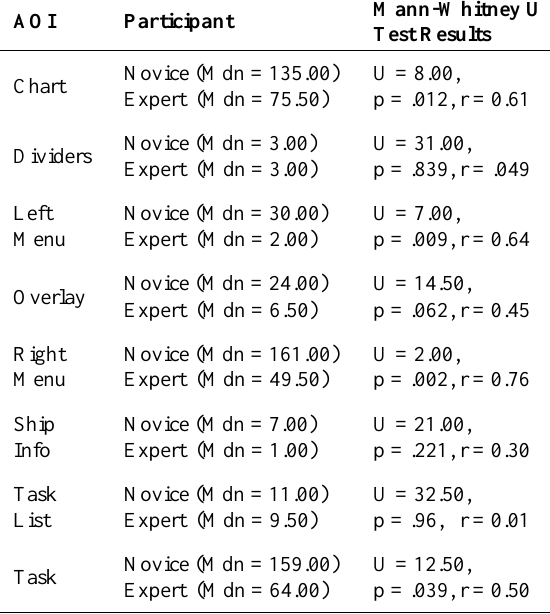
Table 5. Mann-Whitney U Test Results for total fixation counts of novice and expert participants on ecdis